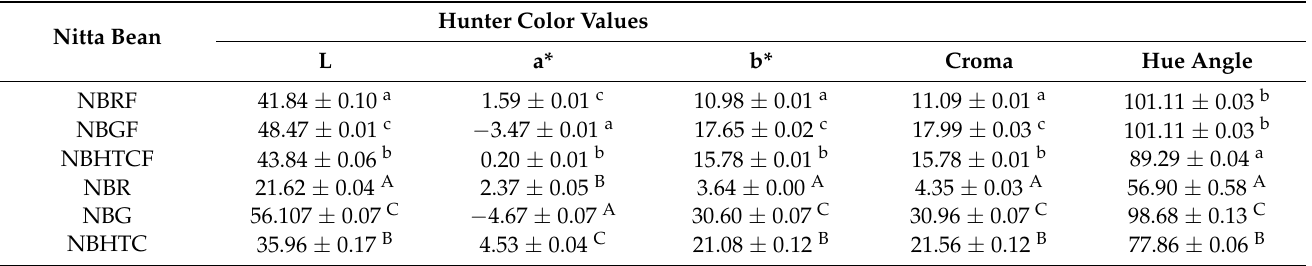
Table 3. The hunter color values of Nitta bean raw, germinated and hydrothermally cooked seeds and their respective